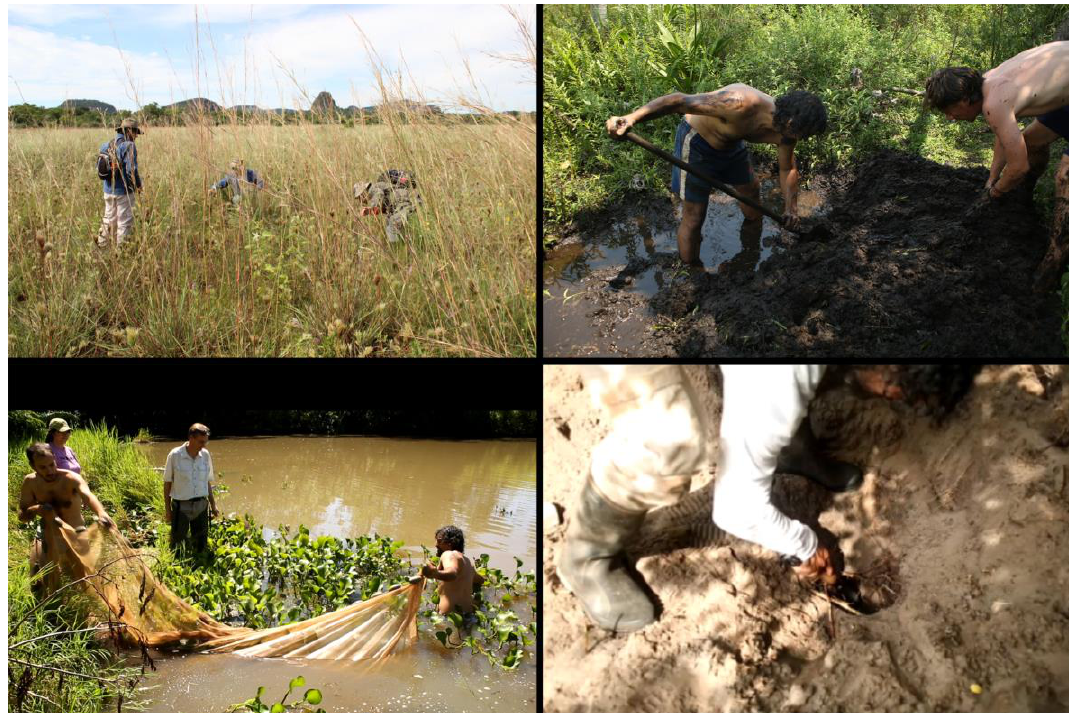
Figure 3. Sampling methods during fieldwork included diverse techniques to search in different environments.